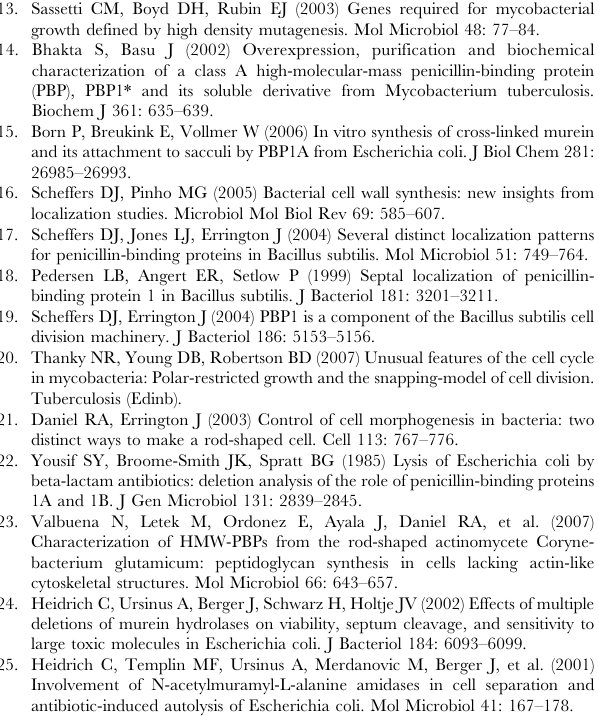
Figure S1 Diagram of ponA1 and ponA2 operons. ponA1 ( rv0050 of M. tuberculosis and MSMEG6900 of M. smegmatis ), is the first gene in an operon with two other genes of unknown function.